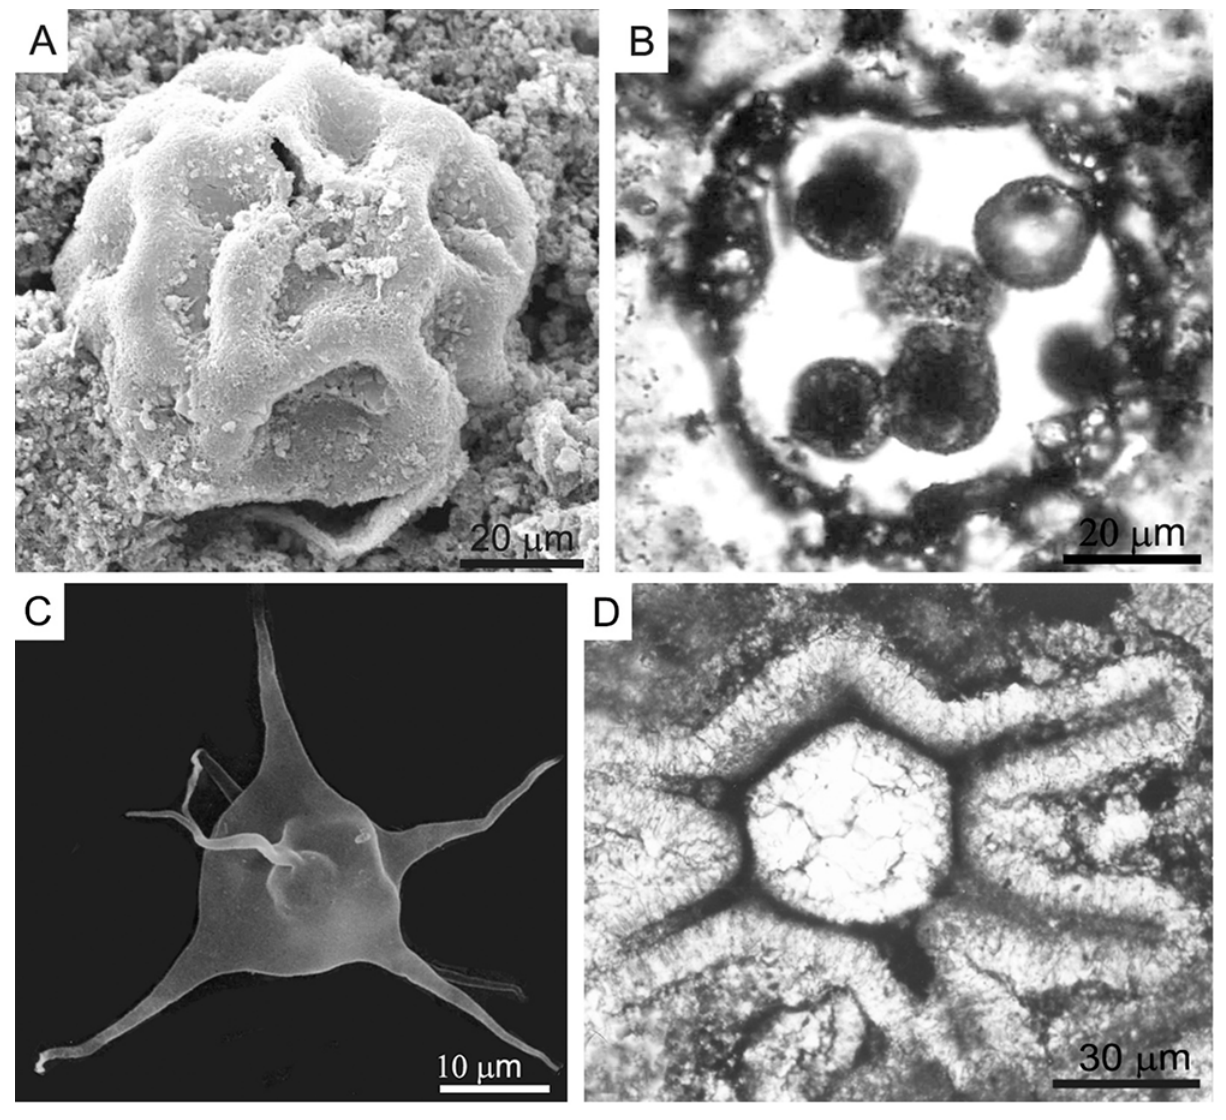
Figure 3 ( A ) Cymatiosphaera , early Silurian (Llandoverian) herkomorph acritarch, scanning electron microscopy (SEM) image (by B. Kremer). ( B ) Cross section of Cymatiosphaera -like specimen from same sample, enclosing spherical aplanospore-like structures comparable with spores of modern unicellular green algae, light microscope image (by J. Kaźmierczak). ( C ) Acritarch Dorsennidium patulum (SEM image), Famennian Chagrin Shale, Ohio (from Wicander, 1974, courtesy of R. Wicander) as forerunner for calcispheric structure shown in ( D ). in-section photomicrographs of Late Devonian calcispheres from Sosnowiec IG-1 borehole (photo J.